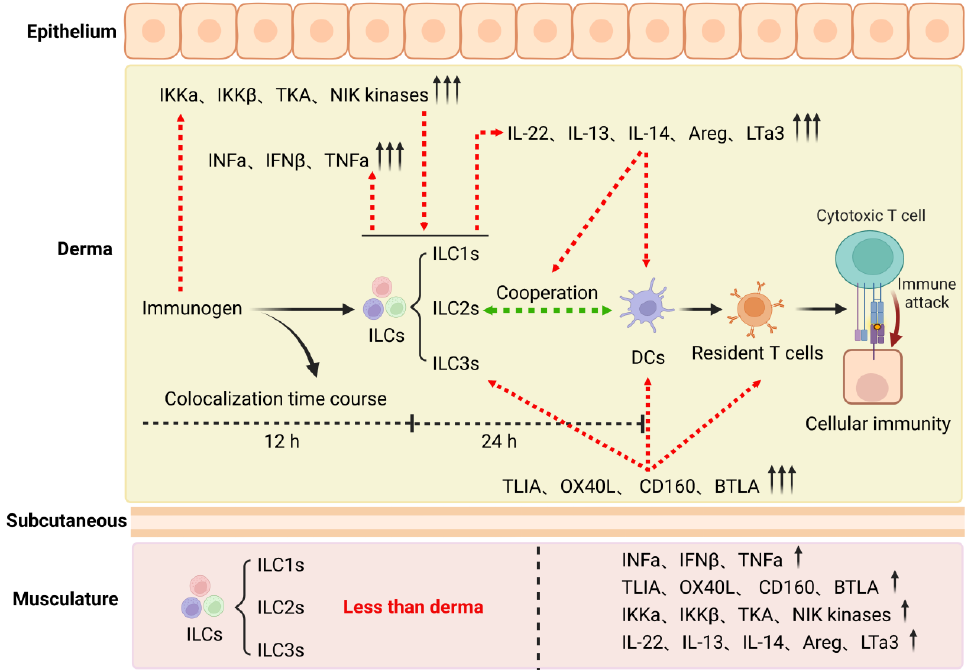
Figure 3. The potential mechanism that intradermal immunization is more effective than intra- muscular immunization. Image created with BioRender (https://biorender.com/, accessed on 10 October